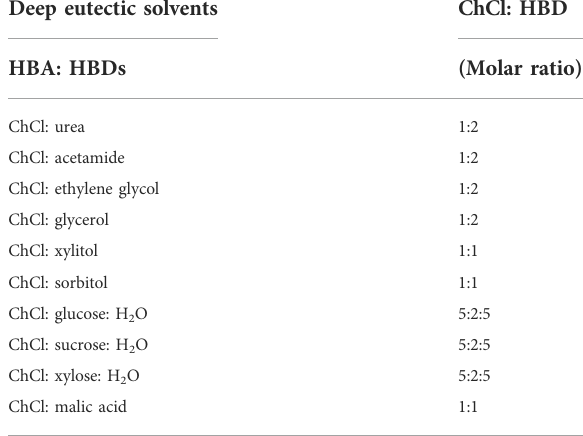
TABLE2MolarratiosusedforthepreparationofcommonChCl-based DESs. Deep eutectic